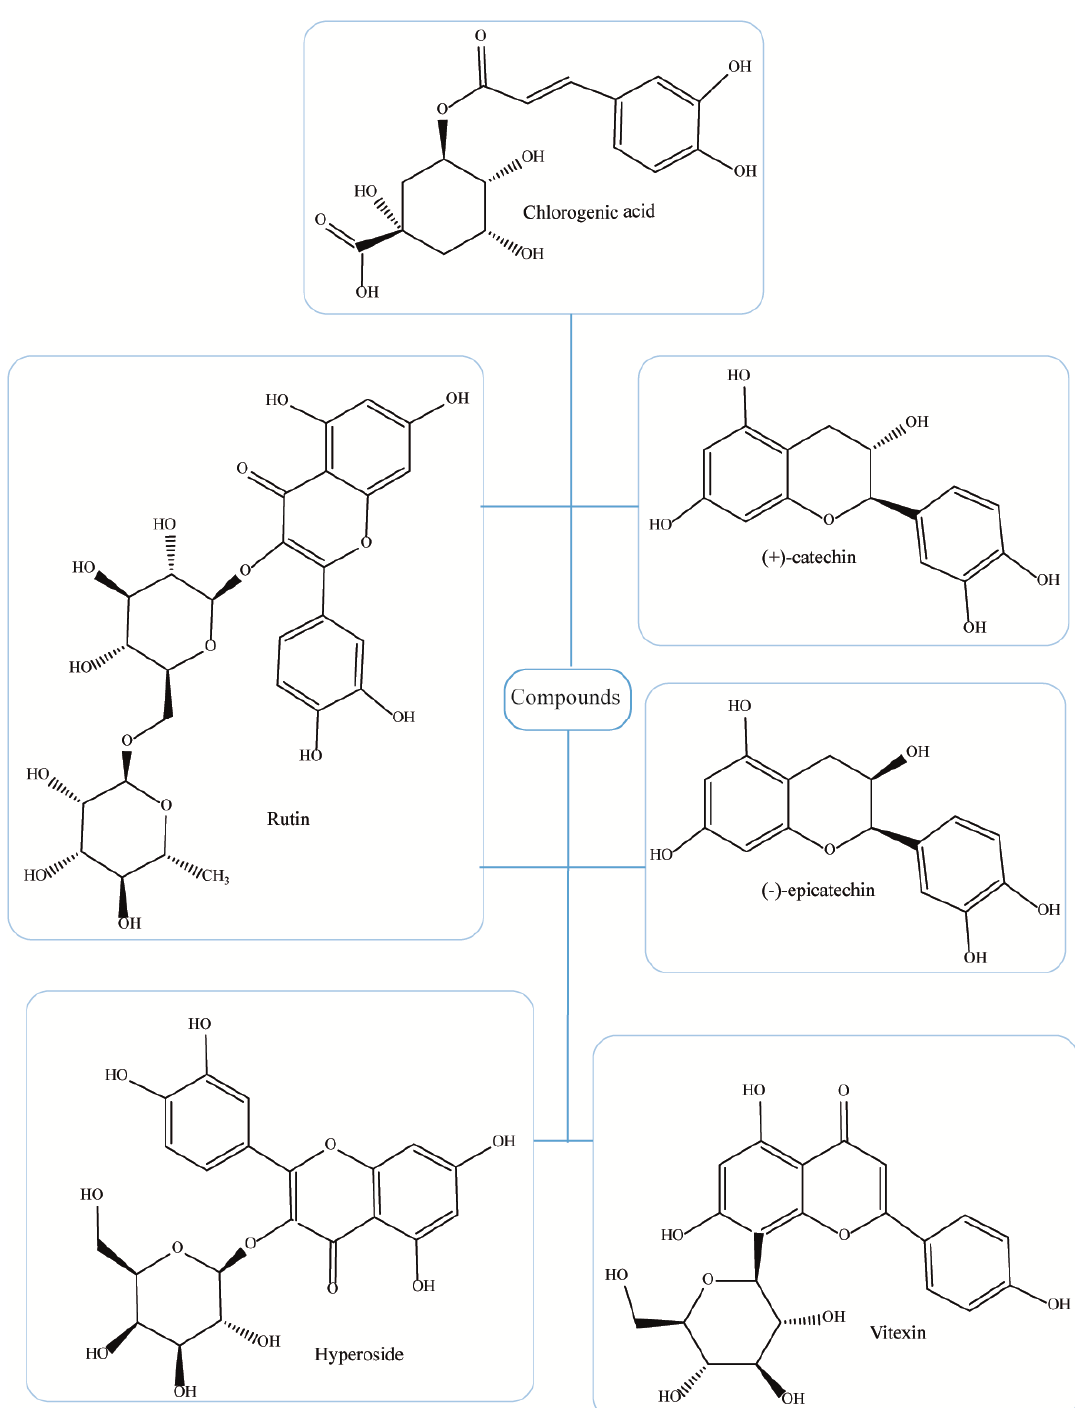
Figure 2. Overview of the main compounds found in hawthorn.